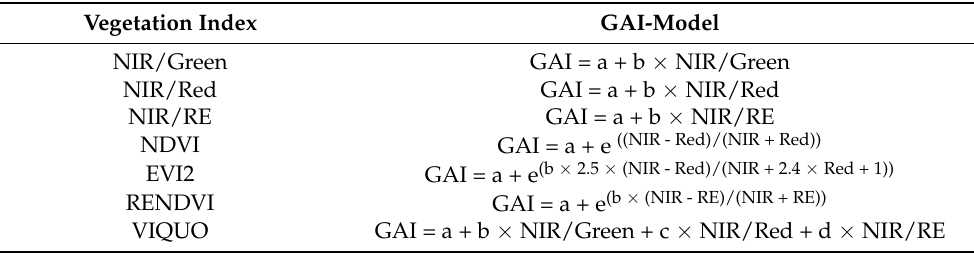
Table 1. Tested vegetation indices to calibrate Sentinel-2 data to the UAV-based GAI of winter wheat (obtained by the combination of UAV data and a corresponding GAI-calibration